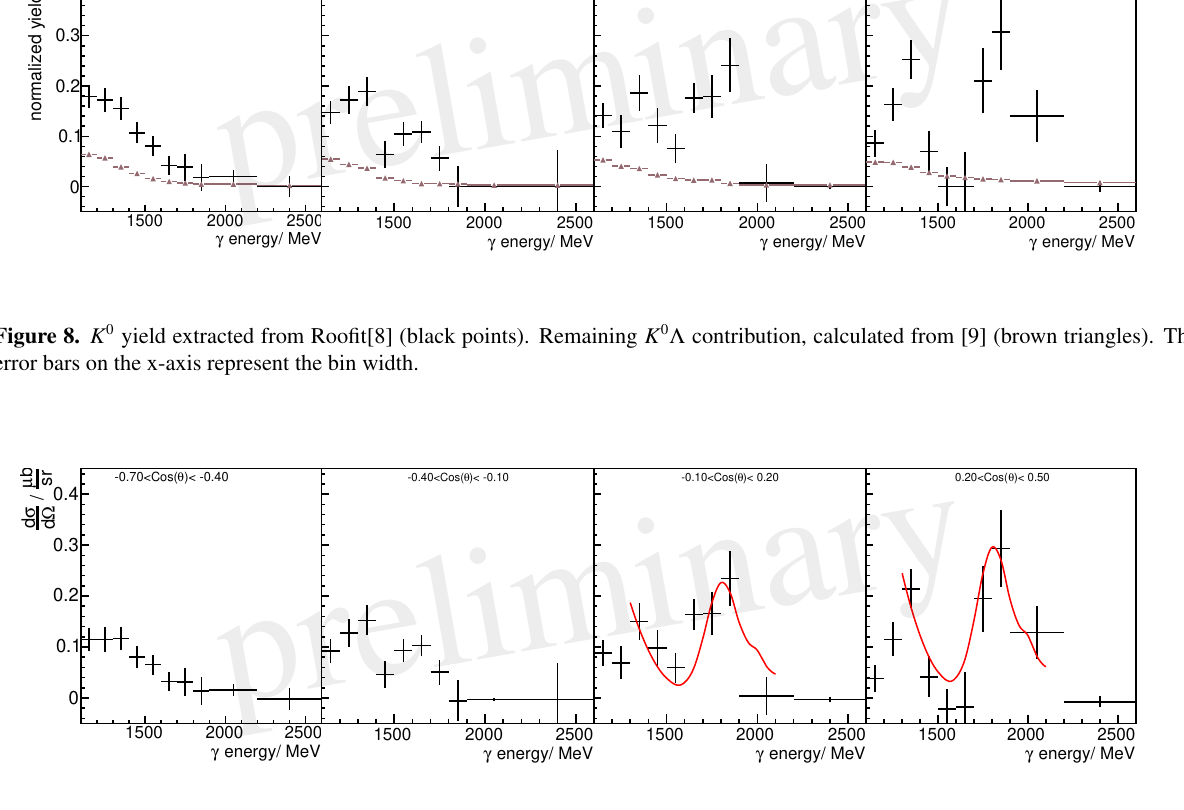
Figure 9. γ n → K 0 Σ 0 di ff erential cross section (black points). Predicted enhancement by Oset and Ramos[6] in an arbitrary scale (red line). The error bars on the x-axis represent the bin